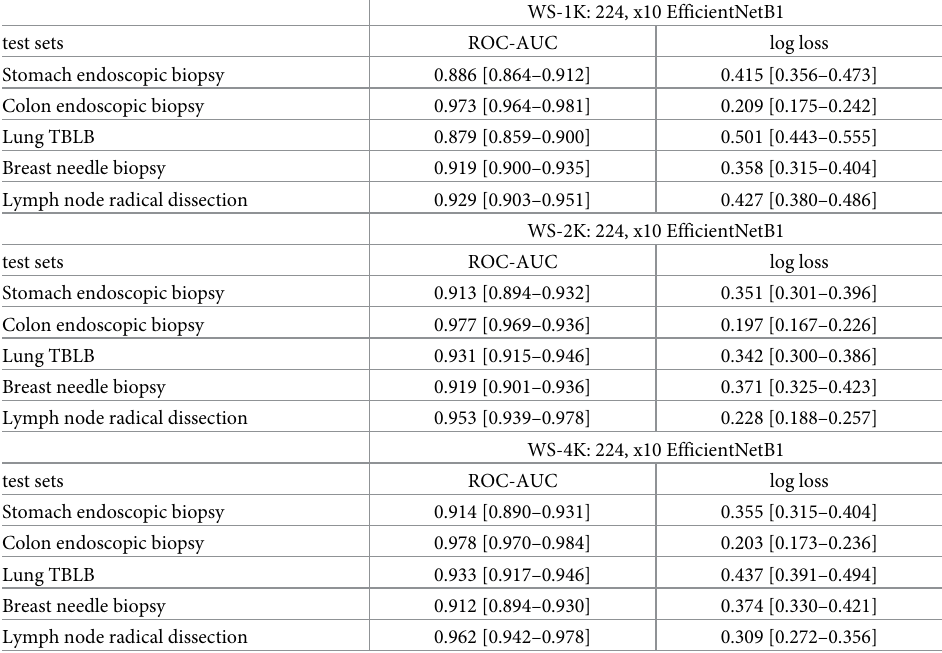
Table 6. ROC-AUC and log loss results for adenocarcinoma classification on test sets using trained models. WS-1K: 224, x10 EfficientNetB1